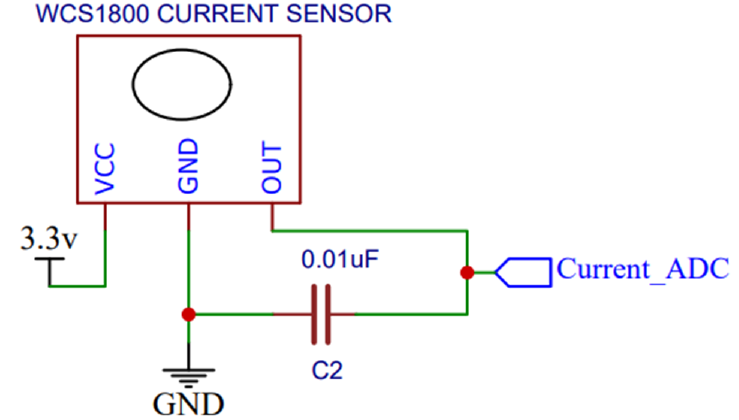
Figure 5. Current measurement